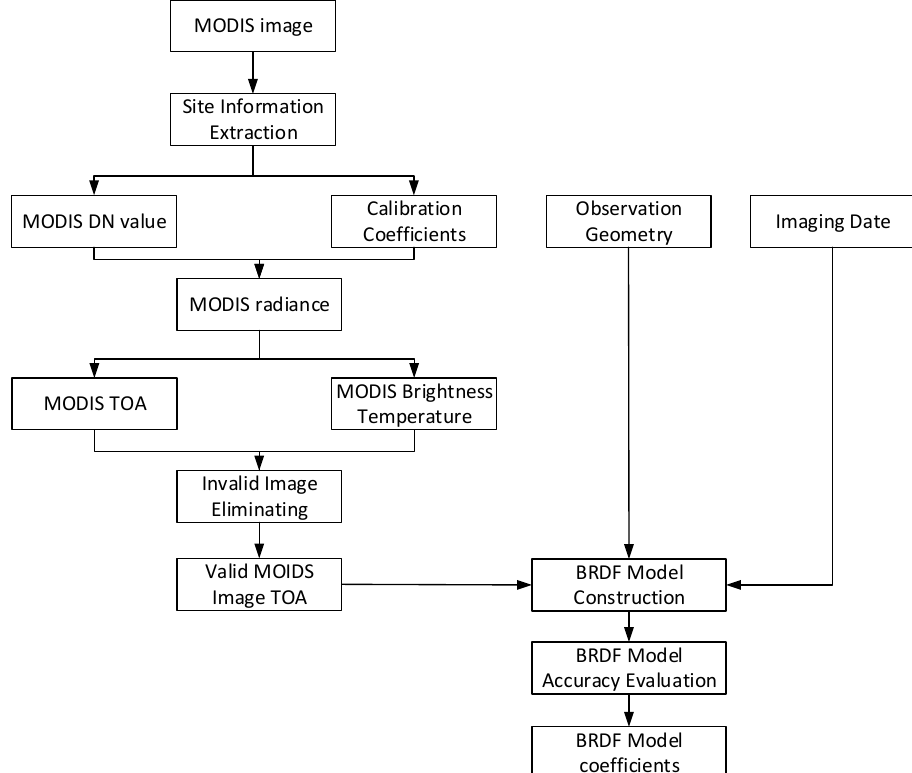
Figure 4. Flow chart of bidirectional reflectance distribution function (BRDF) model construction.